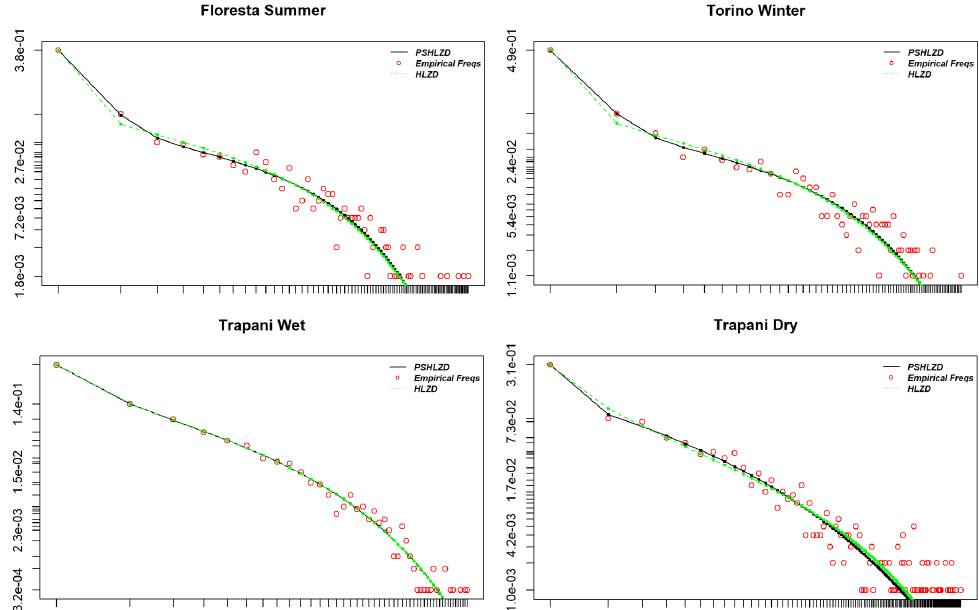
Figure 2. Log-log plots of the fitted HLZD (green dotted line), the fitted PSHLZD (black solid line) and the IT empirical frequencies (red dot line) for the 4 selected samples Floresta Summer , Torino Winter , Trapani Wet and Trapani Dry .